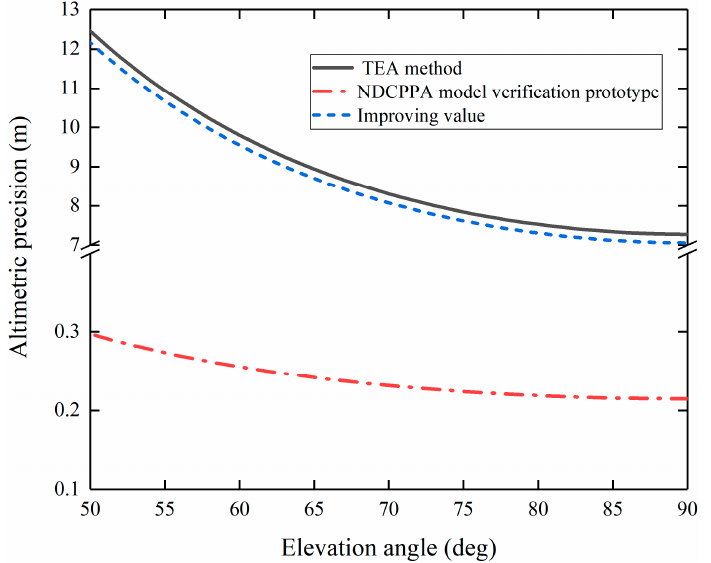
Figure 11. The altimetric precision improvement of the NDCPPA model verification prototype compared to the TEA method.